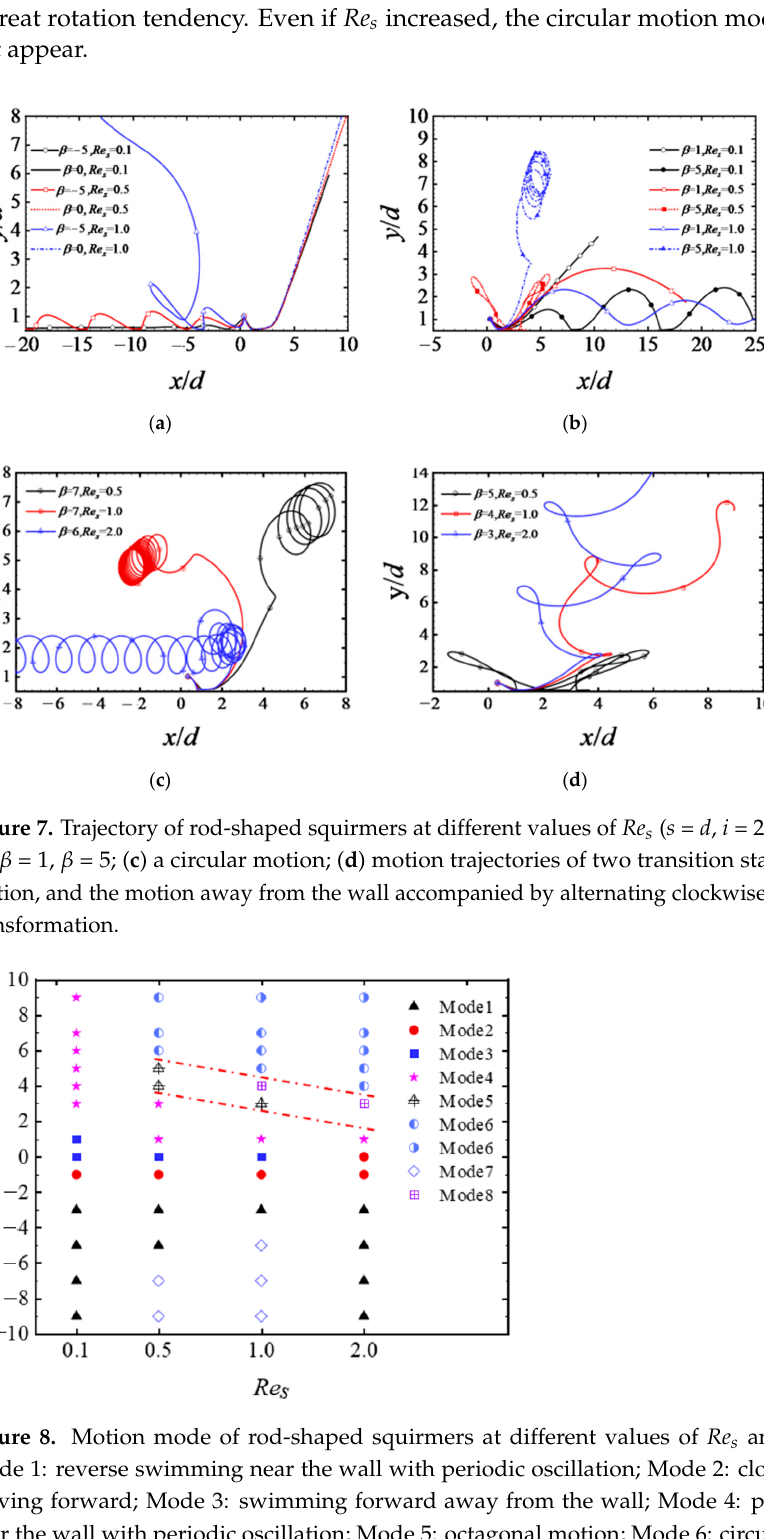
a great rotation tendency. Even if Re s increased, the circular motion mode of pusher did not appear.